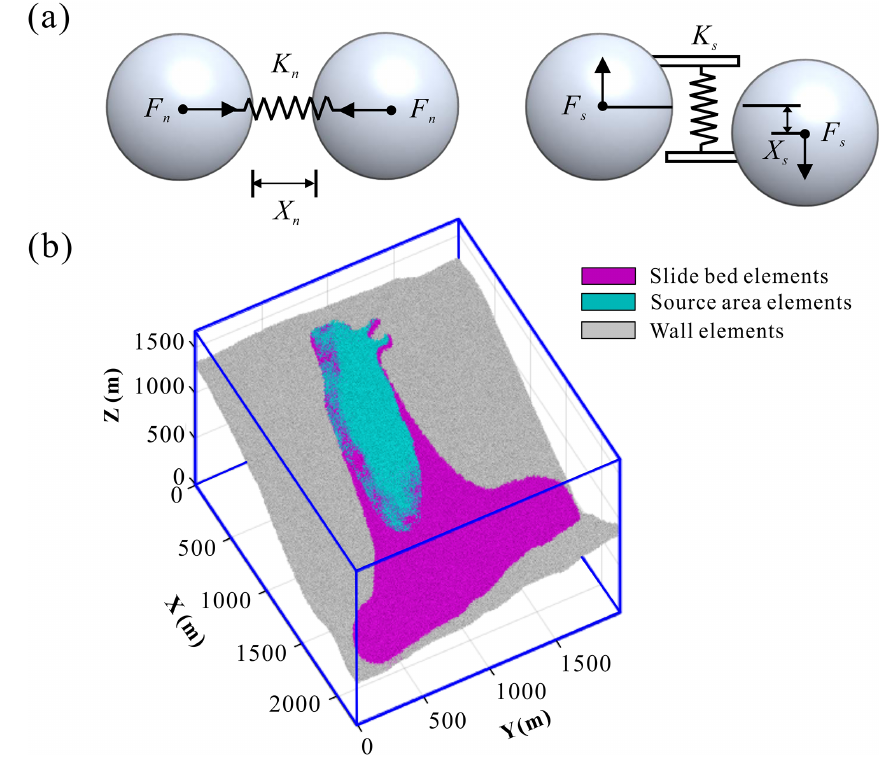
Figure 4. Schematics showing properties of landslide particles and discrete-element model. (a) Linear elastic bonded model. (b) Discrete- element model of the Baige landslide (Fan et al.,